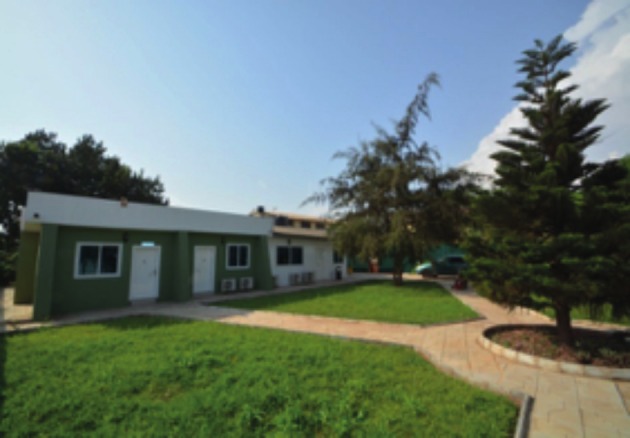
The final result.